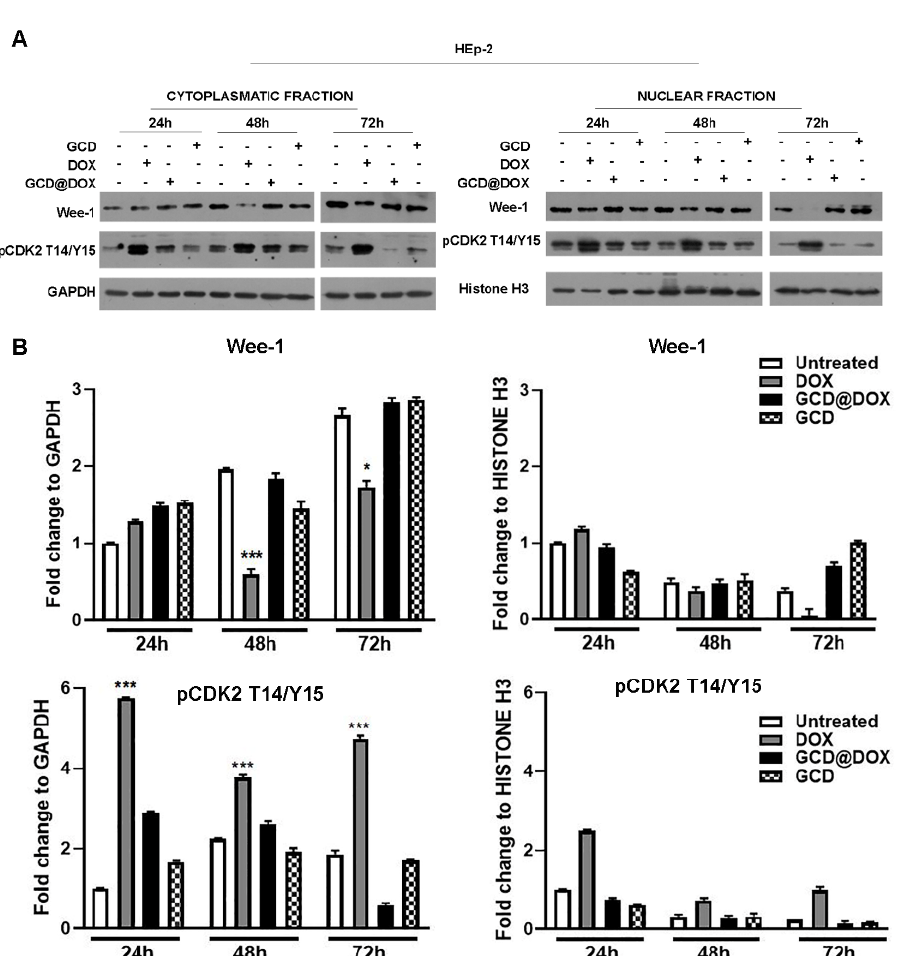
Figure 3. Wee-1 and phospho-CDK2 (pCDK2 T14/Y15) protein expression in GCD@DOX-, GCD- and DOX-treated cells. HEp-2 cells were untreated or untreated with 25 µ g/mL of GCD@DOX for 24 h, 48 h and 72 h. DOX (1.25 µ g/mL) and GCD (25 µ g/mL) were used as controls. ( A ) An equal amount of cytoplasmic and nuclear proteins was separated by polyacrylamide gel electrophoresis and probed with Wee-1 and phospho-CDK2 (pCDK2 T14/Y15) antibodies. GAPDH and Histone H3 were used as a loading control for the cytoplasmic and nuclear fractions, respectively. ( B ) The quantitative densitometric analysis of Wee-1 and pCDK2 T14/Y15 band intensities was determined in the cytoplasmatic and nuclear fractions for both with ImageJ software and expressed as fold change over the appropriate housekeeping gene. (* p < 0.1; *** p < 0.001).